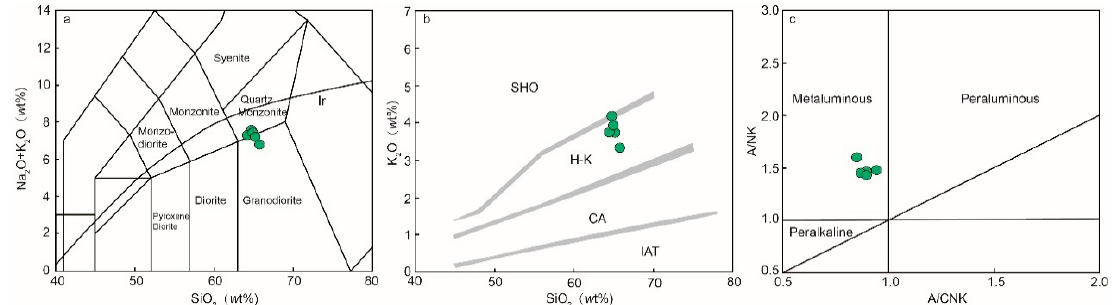
Figure 5. Classification diagrams of lithochemical compositions of Hucunnan granodiorites: ( a ) Total alkali vs. silica (TAS) [49]; ( b ) K 2 O–SiO 2 [50]; ( c ) A/NK vs. A/CNK [51]. Ir—The Irvine dividing line, the top is alkaline, and the bottom is sub-alkaline; SHO—Potassium basalt series; H-K—High potassium calcium basic series; CA—Calc-alkaline series; IAT—Low potassium series. The Hucunnan samples (SiO 2 , 64.49–65.77 wt.%) are granodiorites, based on